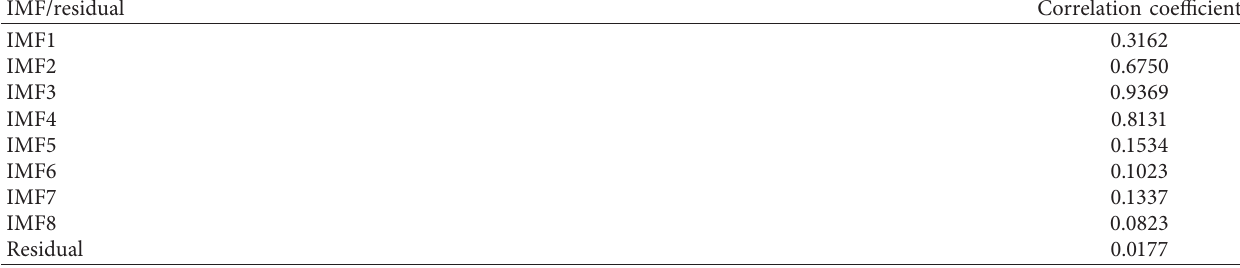
Table 1: The correlation coefficient between the input signal and the IMFs of CEEMDAN. IMF/residual Correlation